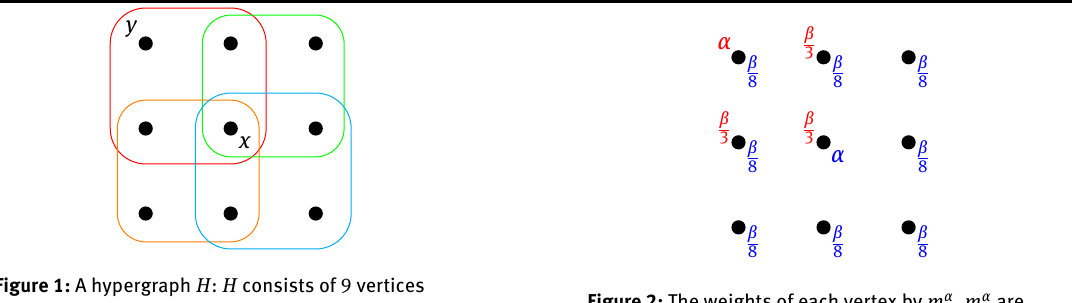
Figure 2: The weights of each vertex by m α x , m α y are drawn in blue and red, respectively. Here, β := 1 − α